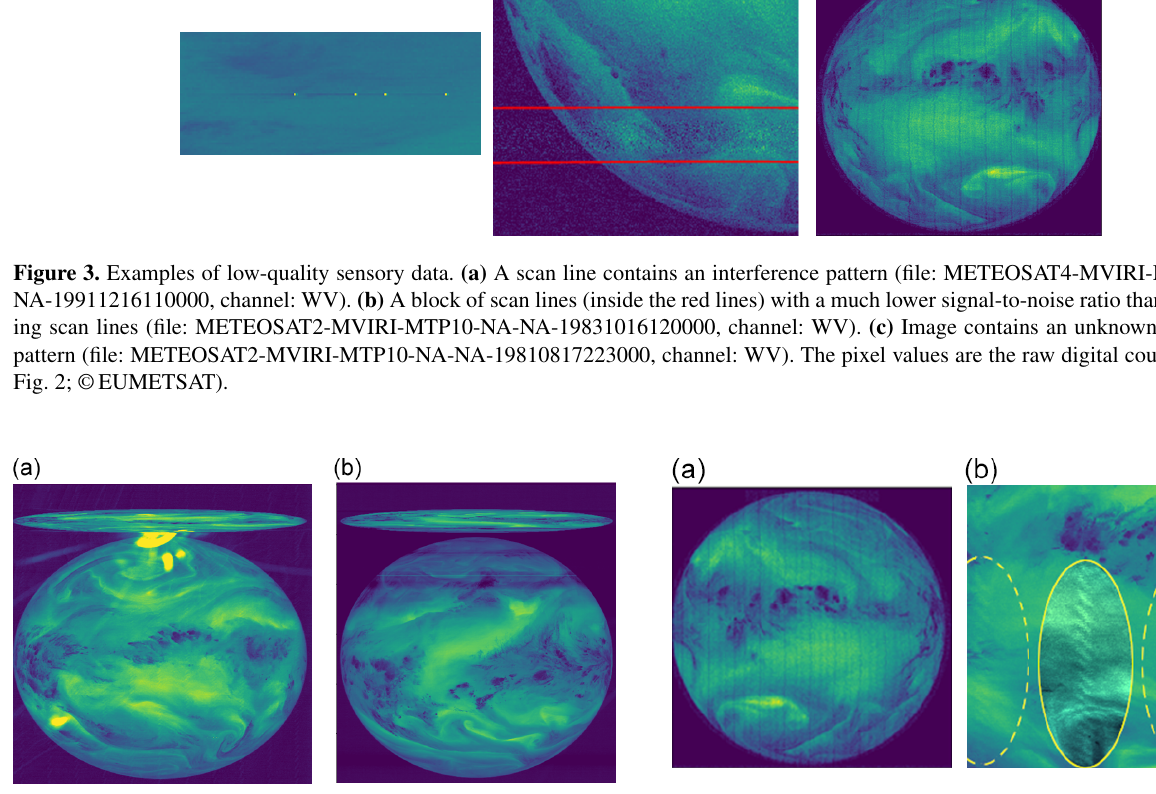
Figure 4. (a) Image affected by a stray-light anomaly (file: METEOSAT4-MVIRI-MTP10-NA-NA-19900415003000, chan- nel: WV). (b) Several hours later, still showing follow-on effects after the stray-light anomaly (file: METEOSAT5-MVIRI-MTP10- NA-NA-20060317213000, channel: WV). The pixel values are the raw digital counts (see also Fig. 2; ©EUMETSAT).